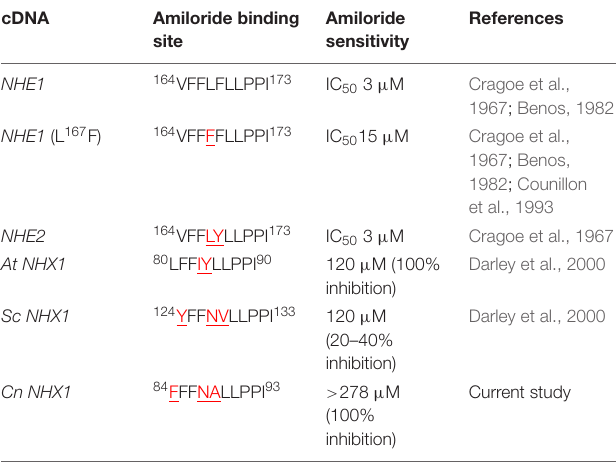
TABLE 1 | Comparison of the amiloride binding site in Na + /H + exchangers of Cryptococcus neoformans, yeast, plants and mammals. cDNA Amiloride binding Amiloride site